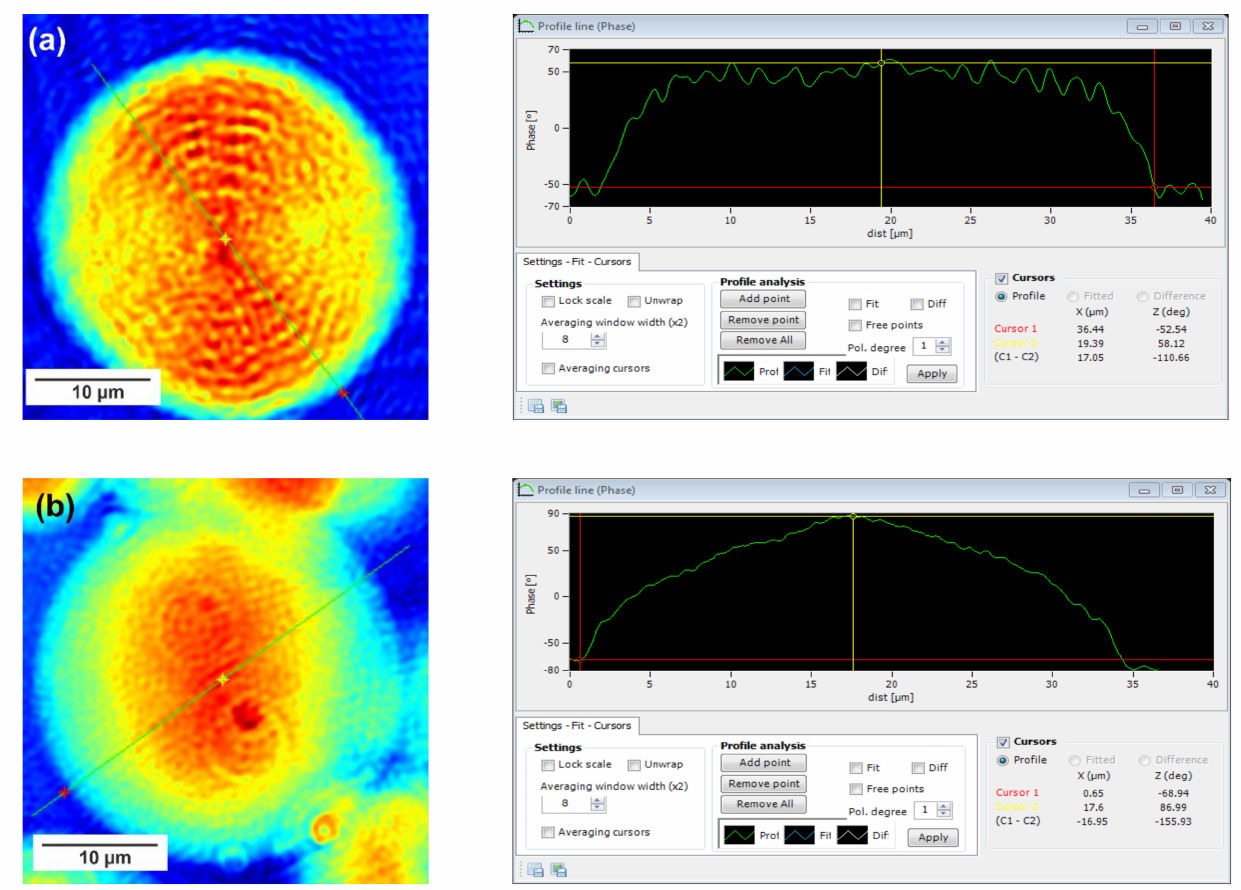
Figure 9. Holographic images and corresponding profiles of the phase changes along the green line recorded for single spherulites crystalized from the melt for ( a ) PBS-DLS 70-30_E and ( b ) PBS-DLS 70-30_M. The DHM microscope magnification is 50 × .